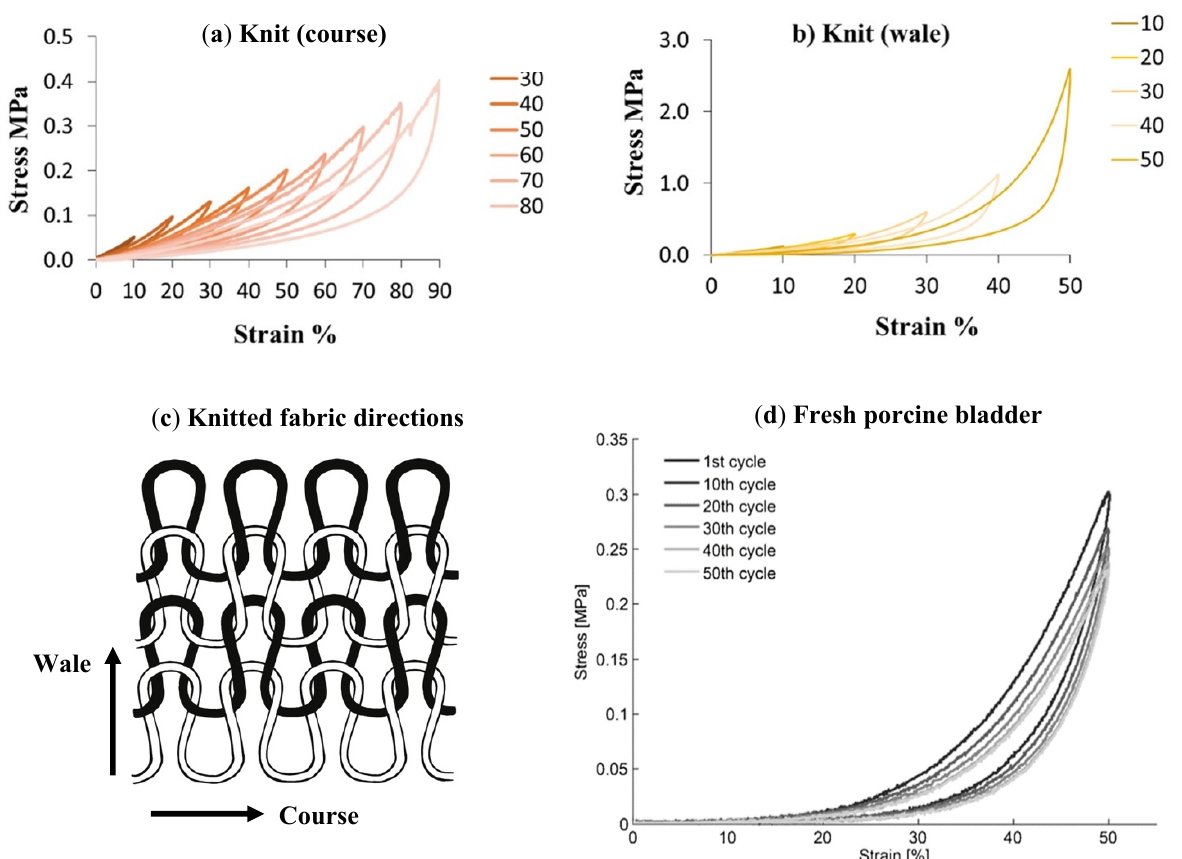
Figure 13. Shows the loading-unloading curves for knit material and fresh porcine bladder. ( a ) Shows the curves obtained from knit tested in the course direction. ( b ) Shows the curves obtained from knit tested in the wale direction. ( c ) Diagram shows the knit directions. ( d ) Shows the curves obtained from fresh porcine bladder. ( a , b ) obtained with permission from [24], ( d ) obtained with permission from [44].